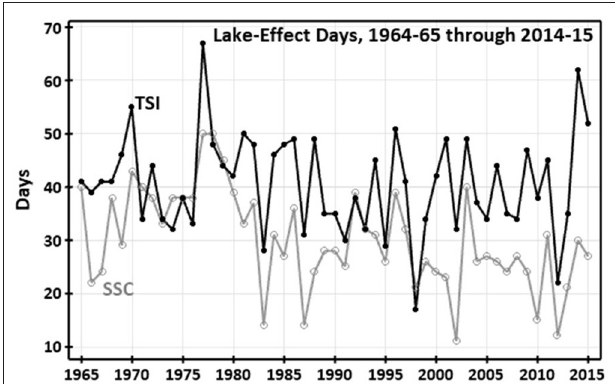
FIGURE 2 | Seasonal number of lake-effect days for the eastern Great Lakes as determined by the TSI (black) and SSC (gray)